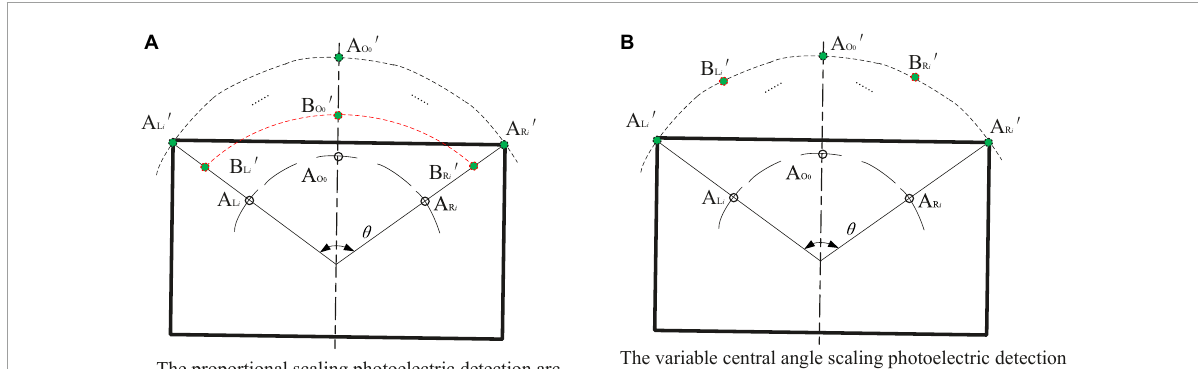
FIGURE9 A schematic diagram of reducing the detection arc.